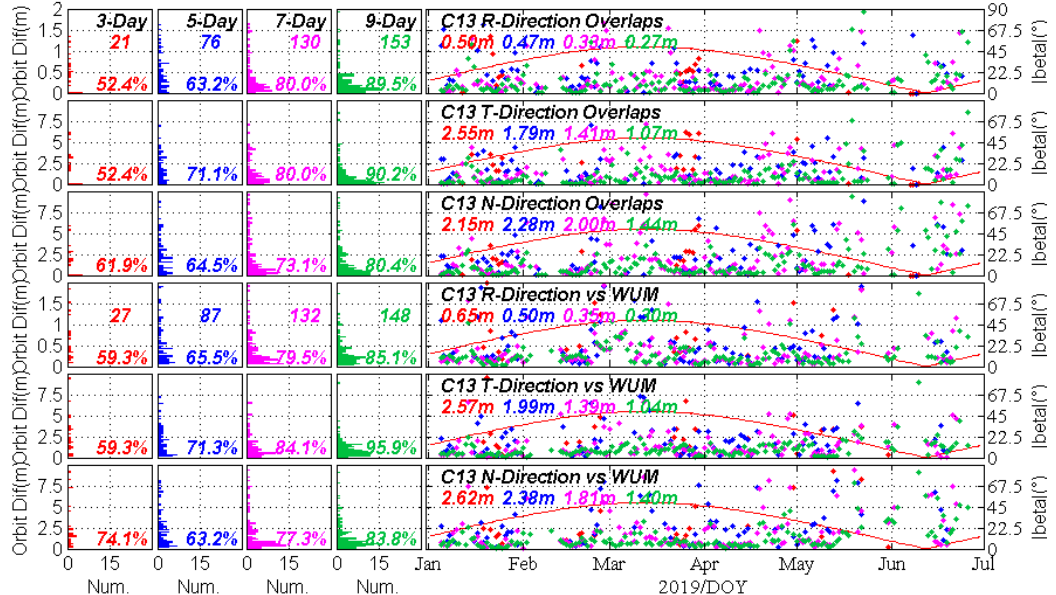
Figure 9. The results of SLR-only orbit determination for C13.